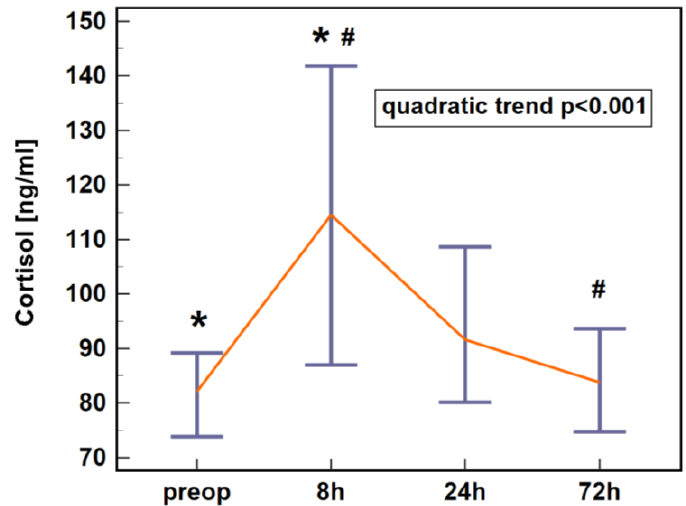
Figure 1. Plasma cortisol dynamics in early postoperative period following colorectal surgery. Data are presented as medians with 95% CI. Data were analyzed following log-transformation using repeated measures analysis of variance ( n = 61). Significant differences between time points are indicated by symbols of the same type (*, #). CI, confidence interval; preop, preoperative; 8 h, 8 h post-incision; 24 h, 24 h post-incision; 72h, 72 h post-incision.